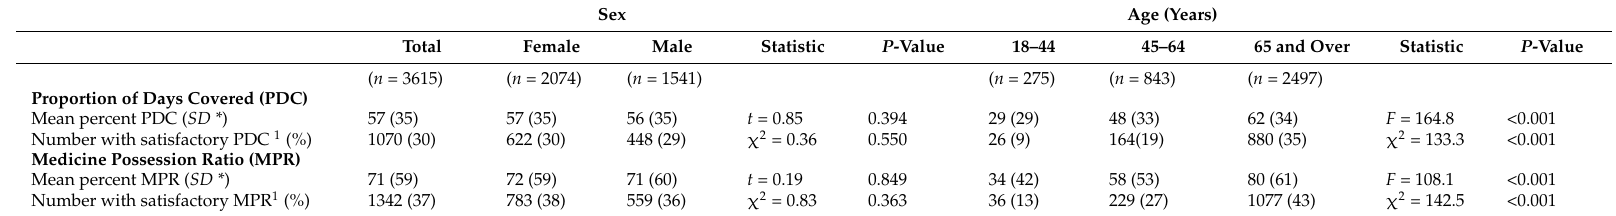
Table 1. Degree of adherence indicated by refill data, the proportion of days covered (PDC) and medicine possession ratio (MPR), by sex and